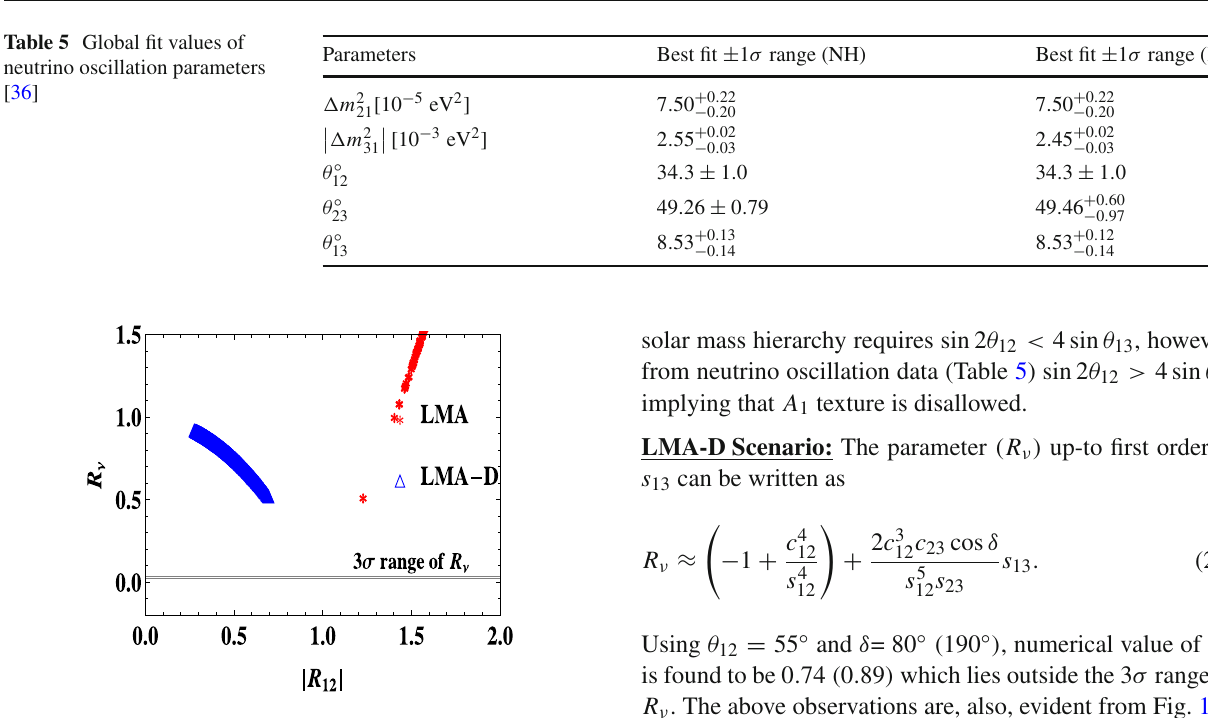
Fig. 1 Correlation between | R 12 | and R ν for texture A 1